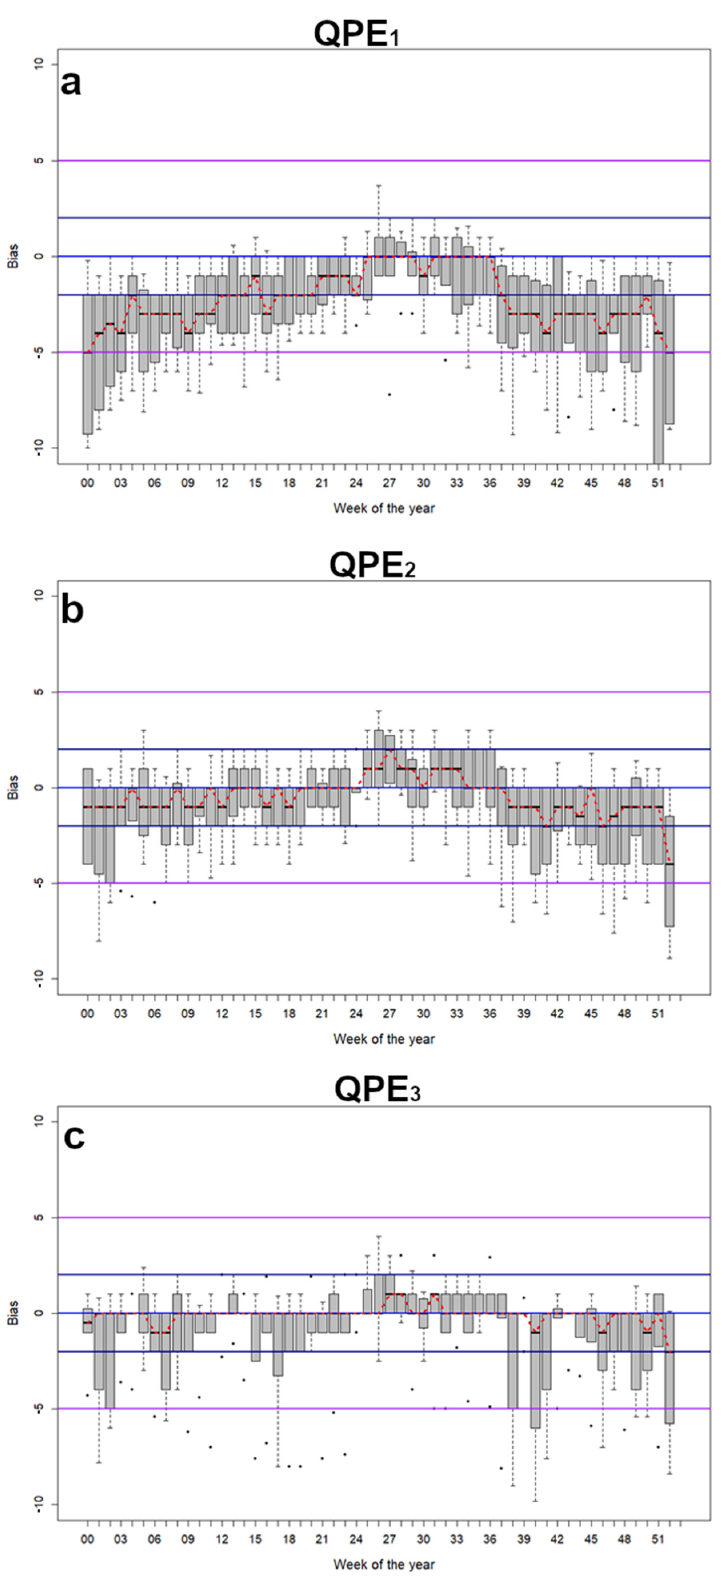
Figure 6. Boxplot showing weeks of the year and bias for the same composite products as in Figure 4 (with simple corrections—panel ( a ), with EHIMI corrections—panel ( b ), and with EHIMI plus rain gauge corrections—panel ( c